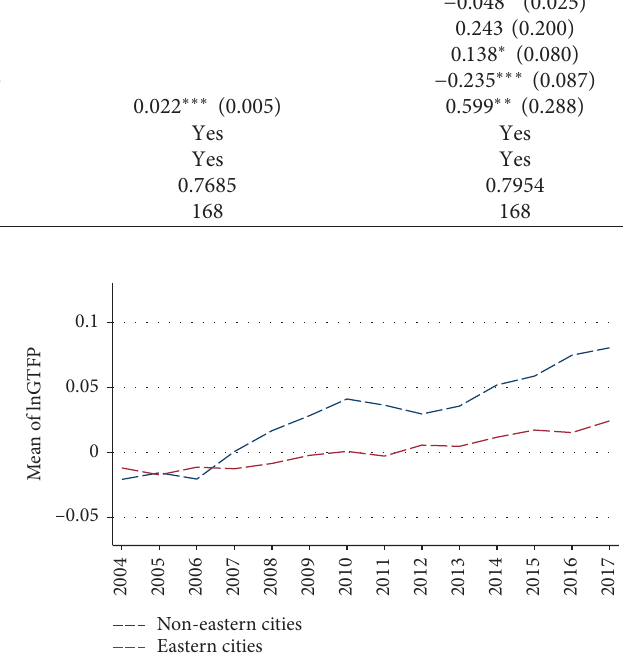
Figure 3: The trend of GTFP of eastern and non-eastern